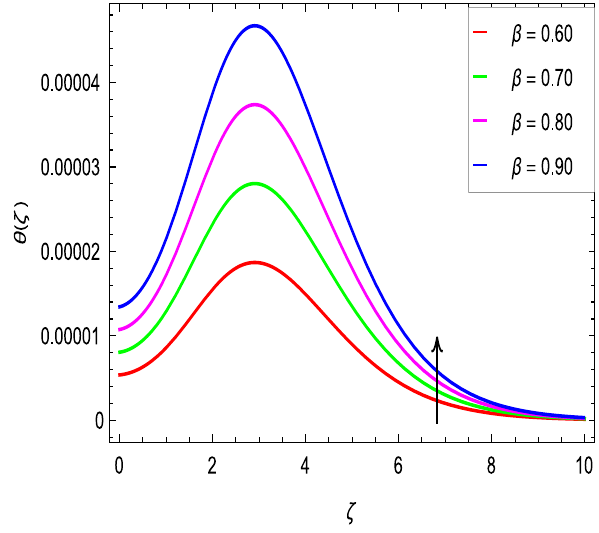
Figure 10. θ(ζ) in terms of β .